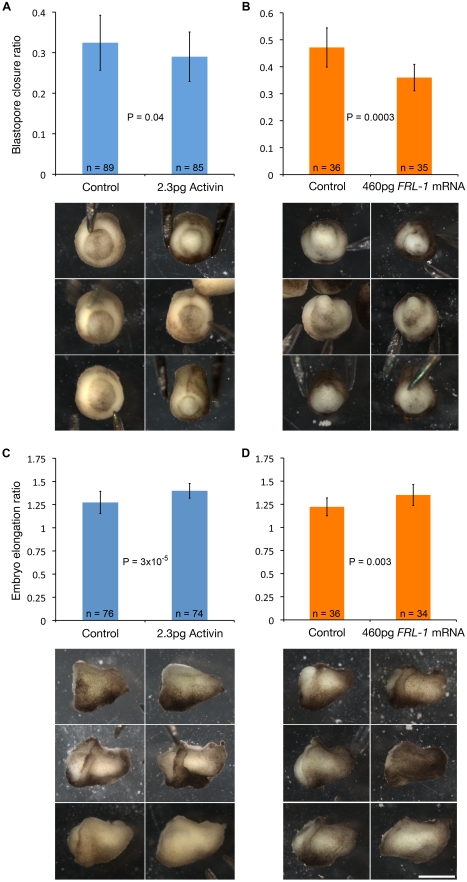
Increased induction signalling partially rescues convergence-extension in whole cybrid embryos.Injection of (A, C) human recombinant Activin A protein into the blastocoel of stage 8, or (B, D) FRL-1 mRNA in the animal half of one-cell [l]xt cybrid embryos, significantly improved (A, B) blastopore closure and (C, D) embryo elongation. Three representative H2O control (left) or Activin/FRL-1-treated (right) embryos are shown below each graph. The blastopore closure ratio (blastopore area/embryo area) was calculated from the respective diameters of the blastopore and embryo at 22 h post-fertilization. The embryo elongation ratio was obtained by dividing the embryo length by the greatest of the height or width at 32 or 46 h post-fertilization. Error bars represent the standard deviation between the means of 4 (Activin) or 3 (FRL-1) replicate experiments. p values were obtained using the one-tailed t test. n, sample size. Scale bar: 1 mm.